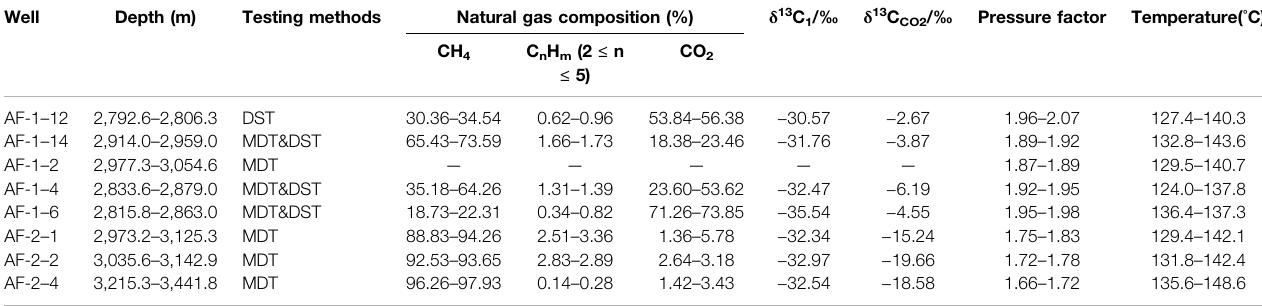
TABLE 1 | Results of natural gas compositions, stable isotope, formation pressure and temperature of wells from drilling tests in the Huangliu sandstones. MDT: modular formation dynamics tester; DST: drill stem testing. Well Depth